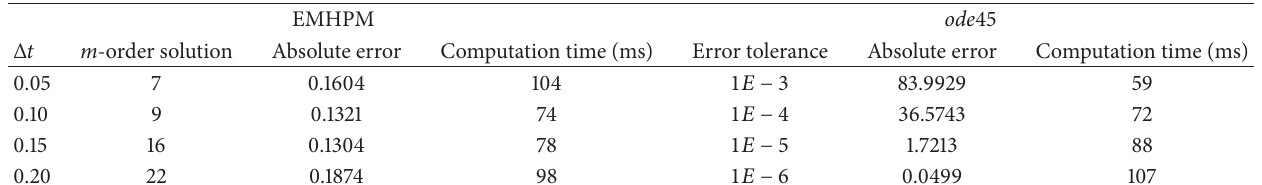
Table 1: Computation time and absolute error comparisons.